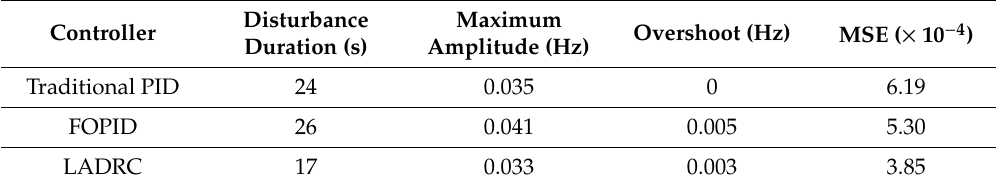
Table 3. Error evaluate of controllers under load